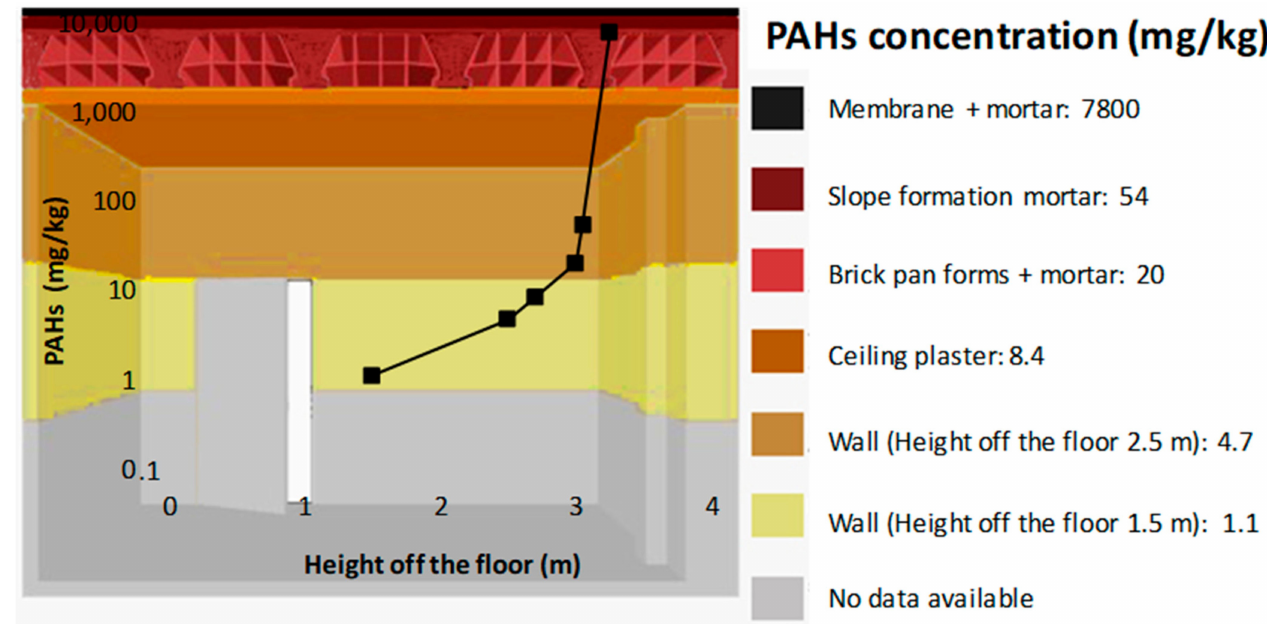
Figure 4. Variation in PAH concentration in materials with